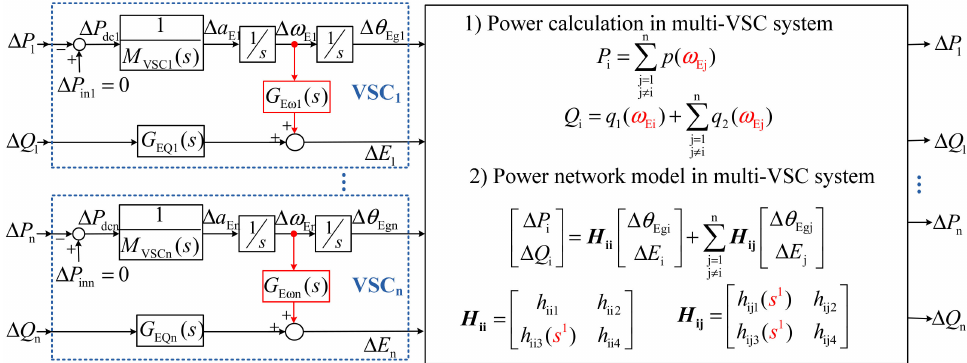
Figure 17. Schematic diagram of multi-VSC system modeling in DVC timescale with the proposed power calculation